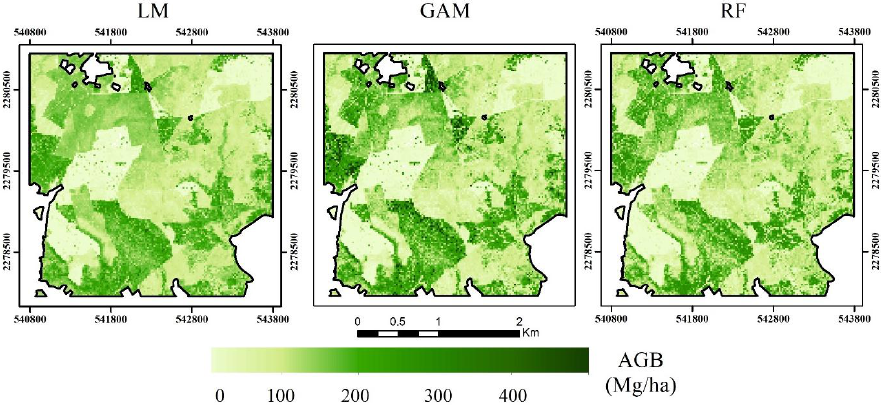
Figure 5. Spatial variability of AGB (Mg ha −1 ) by LM (Linear Model), GAM (Generalized Additive Model), and RF (Random Forest) at the managed forest landscape in the Zacualtipán forested region (3 × 3 km area). Developed areas and areas without forest vegetation were excluded.